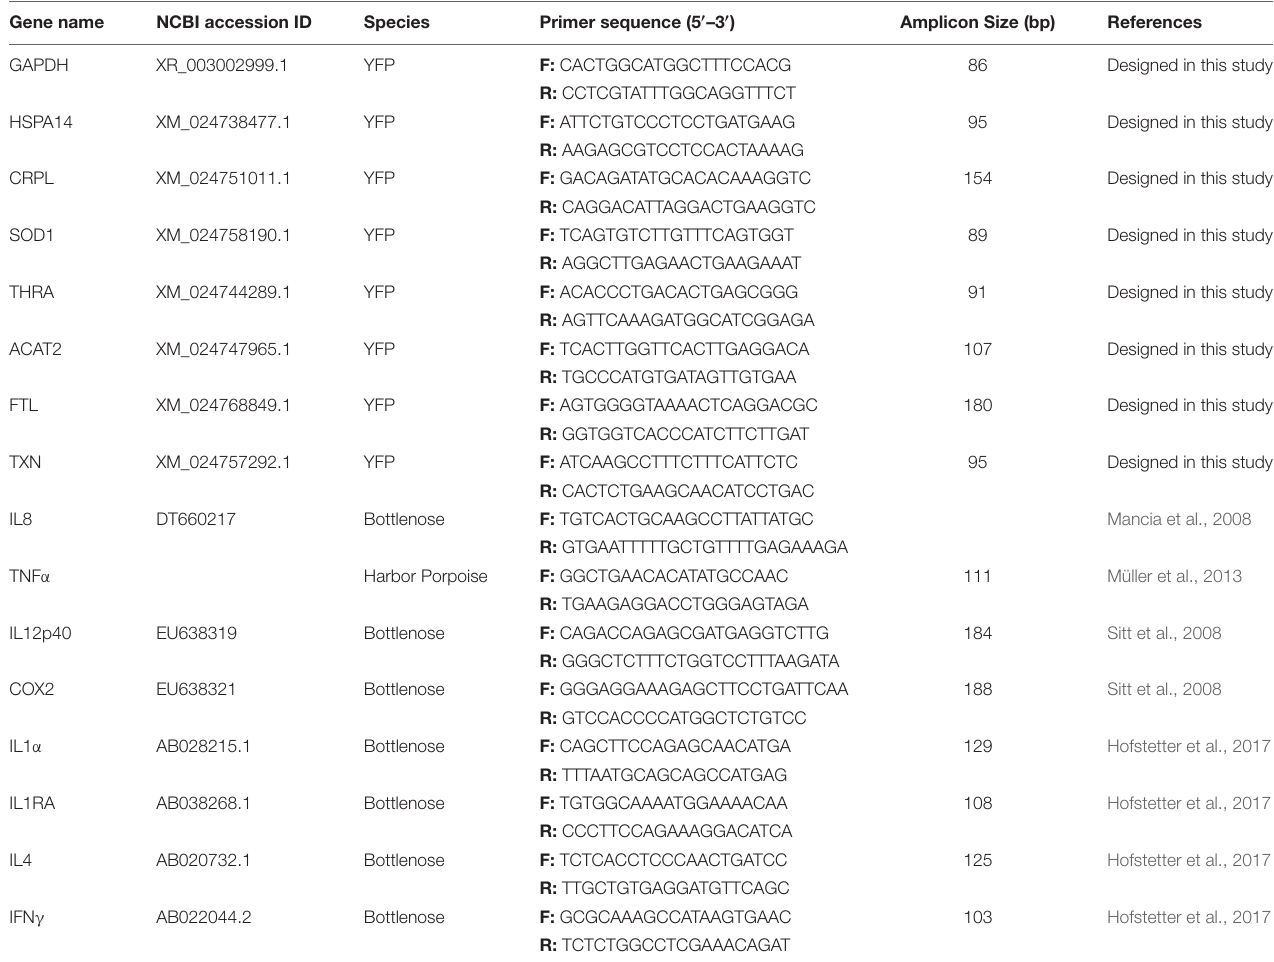
TABLE 2 | Detail information of the